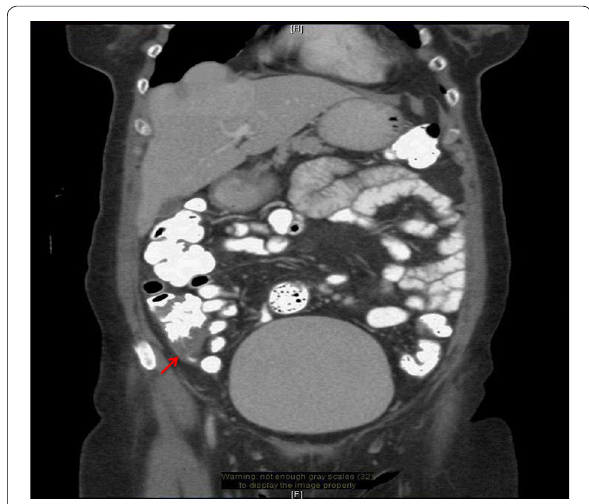
Fig. 2 CT scan shows thickening and inflammatory change of a tubular structure extending from the base of the cecum, surrounding with inflammatory